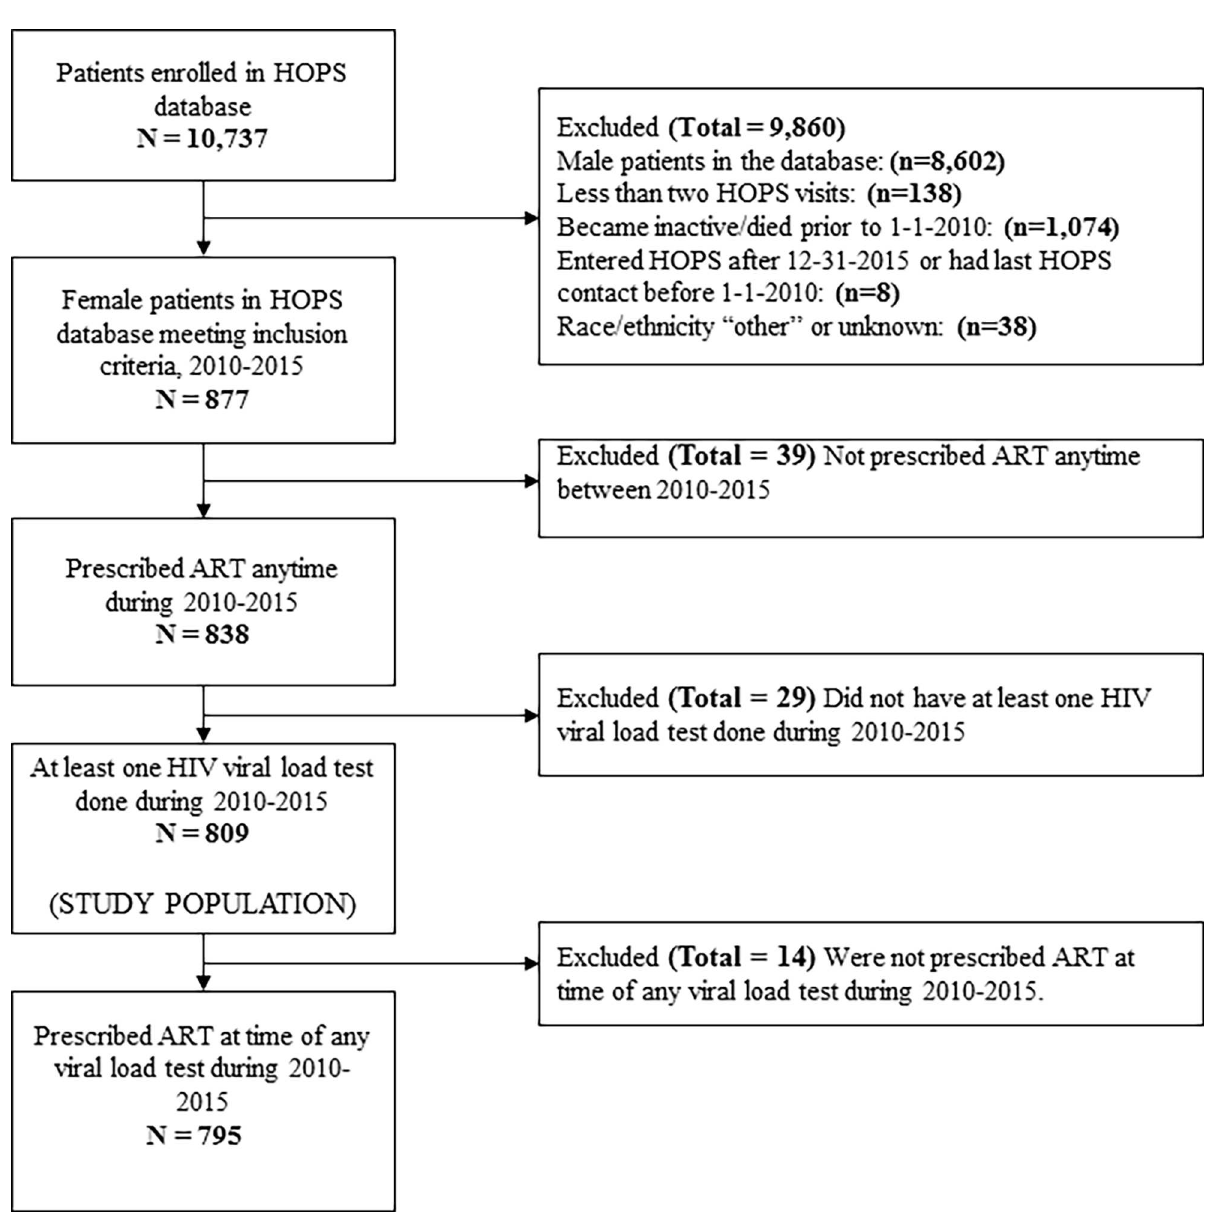
Fig 1. Selection steps flowchart of HOPS participants included in the analysis.